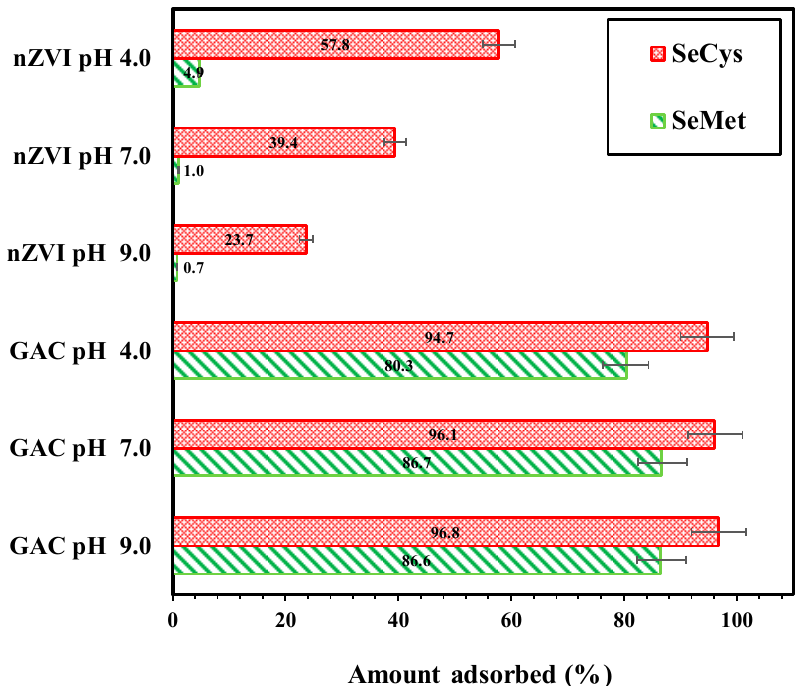
Figure 4. Effect of pH on SeMet and SeCys adsorption by GAC and nZVI, (initial concentration 5 mg/L, 7 g/L, pH 4.0, 7.0 and 9.0, at 25 °C).